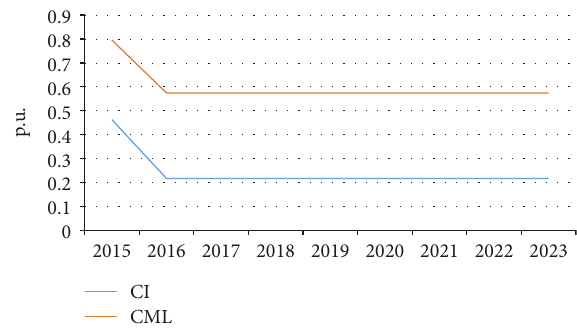
Figure 10: CML and CI; DECC4, 2015 –